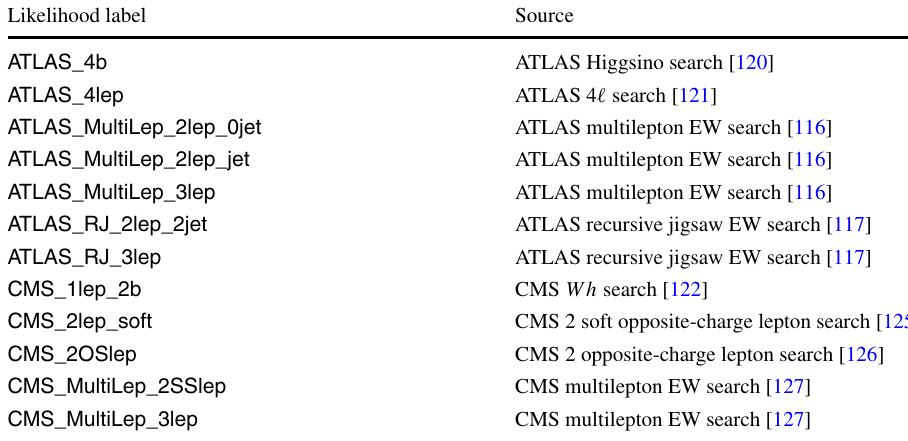
Likelihood label